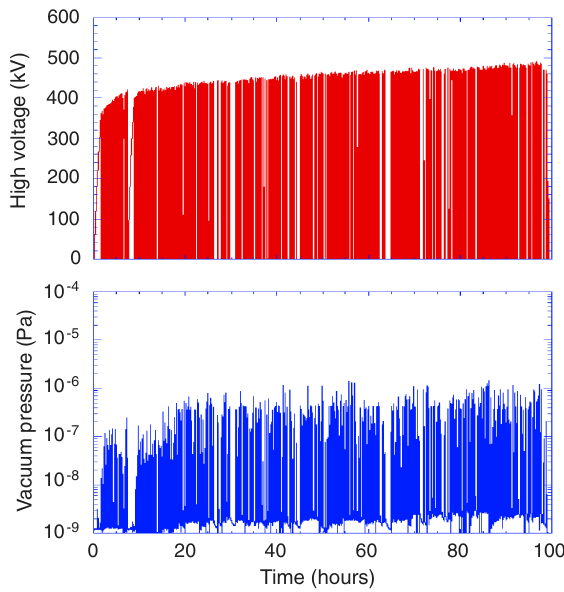
FIG. 4. High voltage (top) and vacuum pressure (bottom) as a function of time during HV conditioning for gun configuration (A), shown in Fig. 3(a); acceleration gap between cathode and anode electrodes was 100